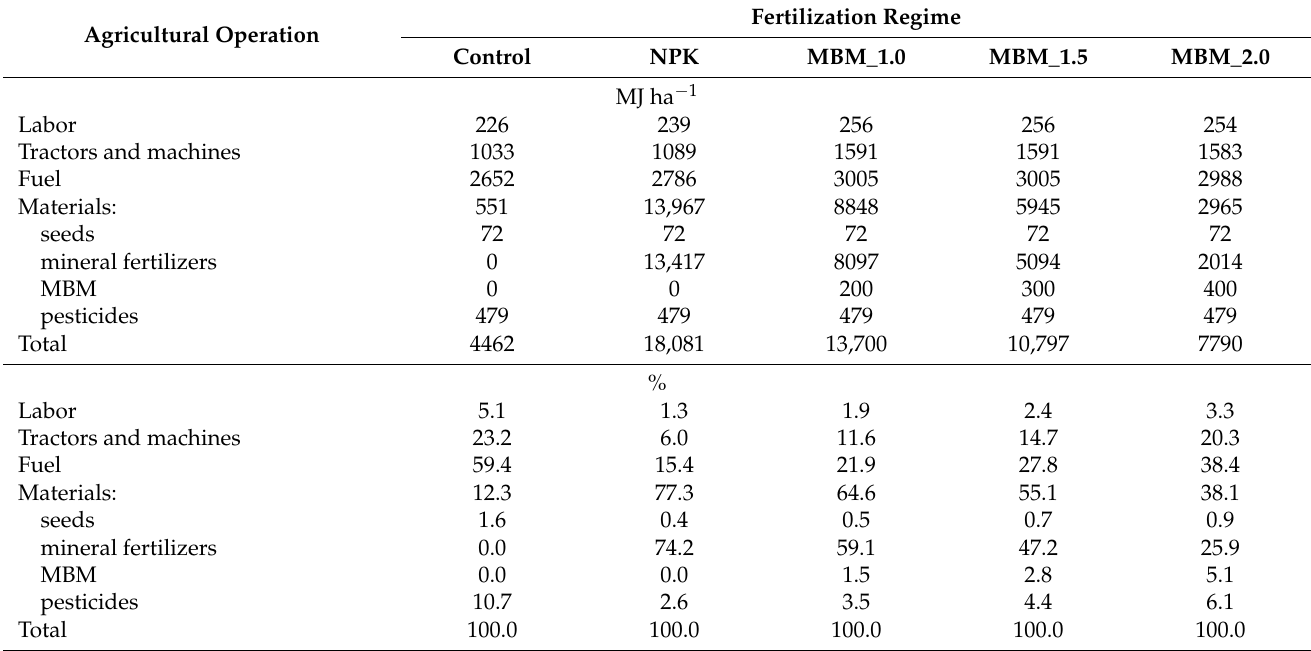
Table 6. Energy inputs associated with the production of winter oilseed rape per energy flux (across